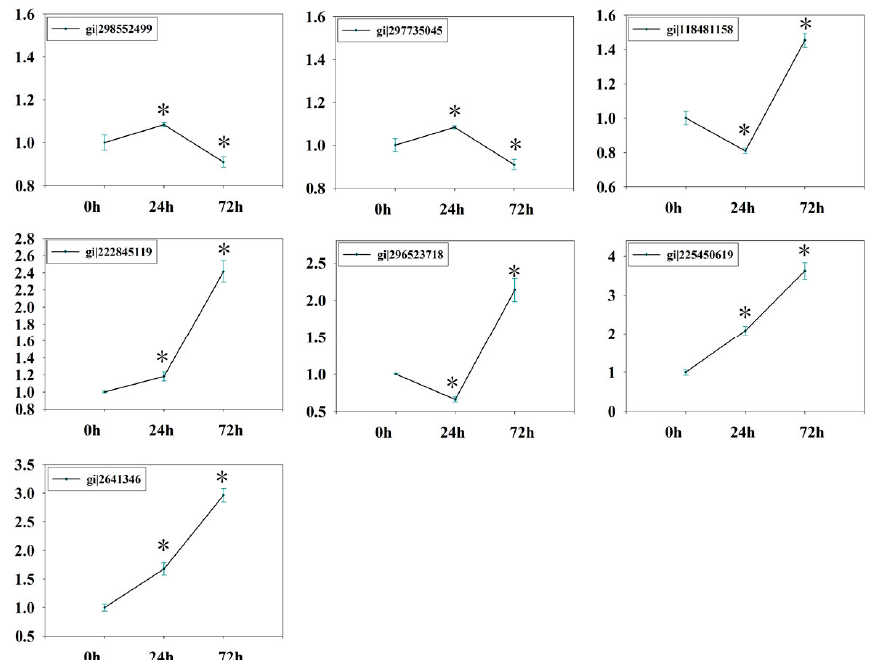
Figure 10. qPCR data for the mRNA expression levels of genes for drought-responsive proteins mapped in glycolytic/gluconeogenetic pathway in roots of ramie. The values represent relative mRNA levels against control groups (0 h samples), values of which were all set to 1 unit. Statistically significant differences in gene expression are indicated with asterisks: * p < 0.05.